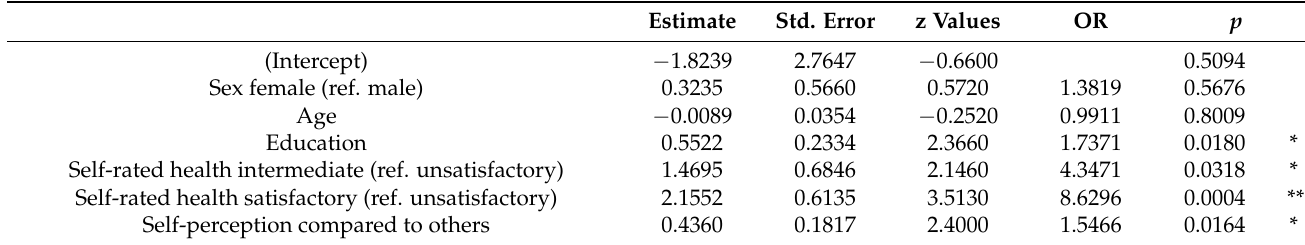
Table 1. General linear model of oQOL regressing on sex, age, education, self-rated health, and self-perception compared to